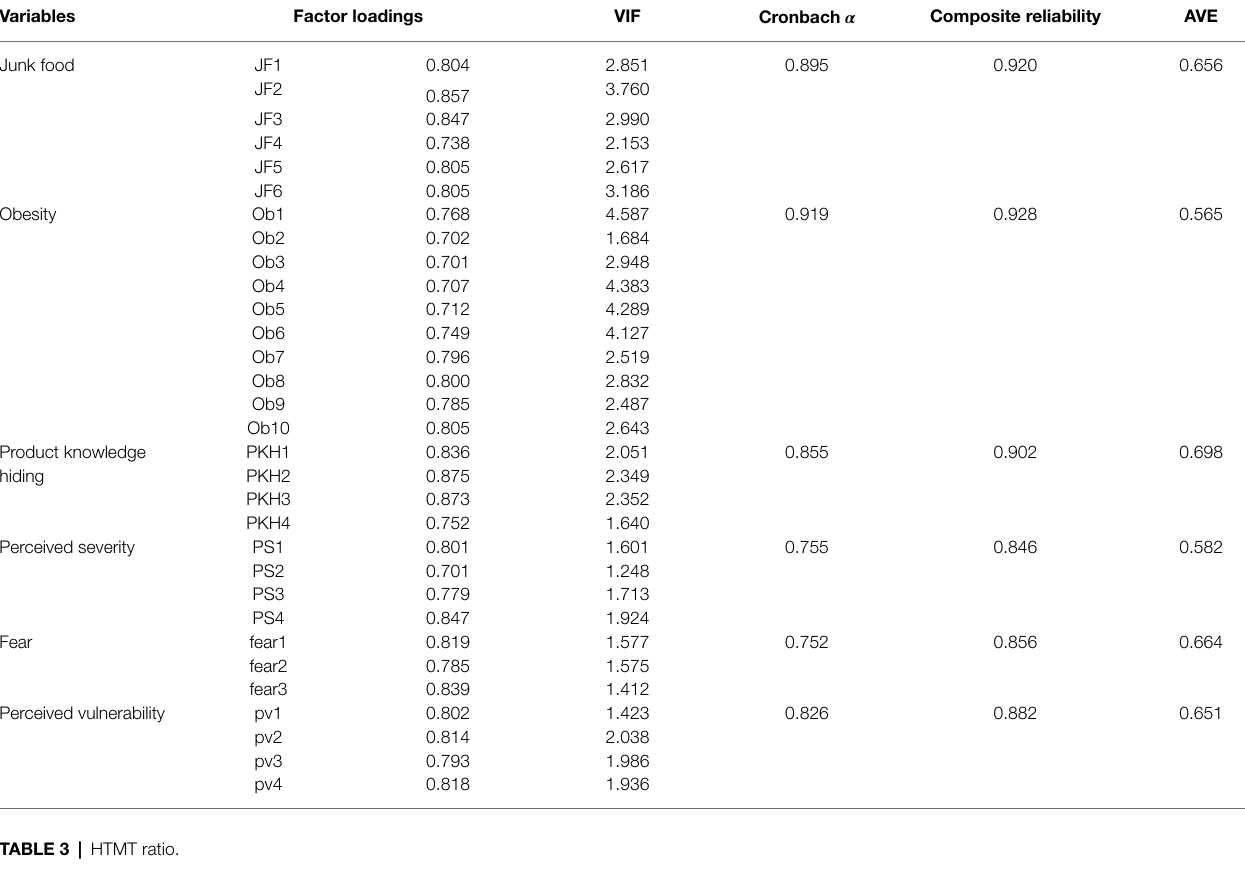
TABLE 2 | Factor loadings, reliabilities, VIF, and AVE.